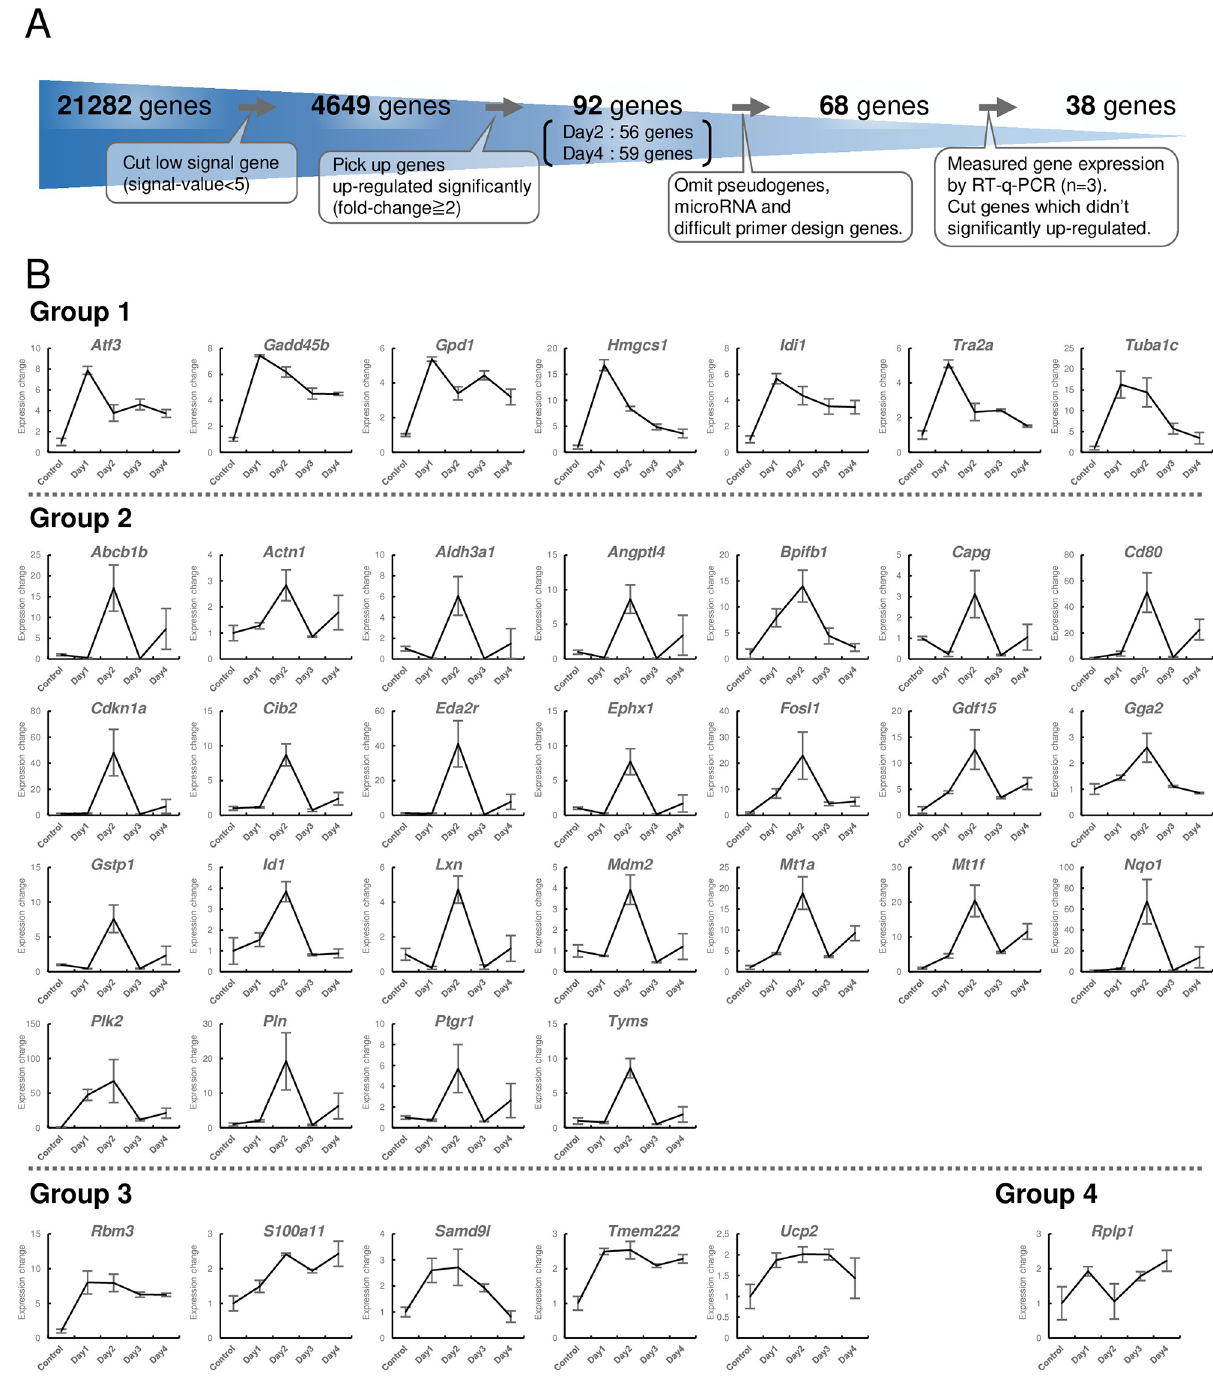
Fig 4. Quantitative analysis of changes in gene expression levels. (A) The process of narrowing down genes that were significantly altered by MMS treatment. (B) Quantitative gene expression analysis by RT-qPCR (biological replicates, n = 3 /group) (S1 Fig). Gene expression levels of 38 genes extracted by the method in (A) were measured at 1, 2, 3, 4 days after MMS treatment and in Control samples, Changes in gene expression levels over time were tracked and are represented in a line graph. Genes were classified into four groups according to the pattern of expression level changes over